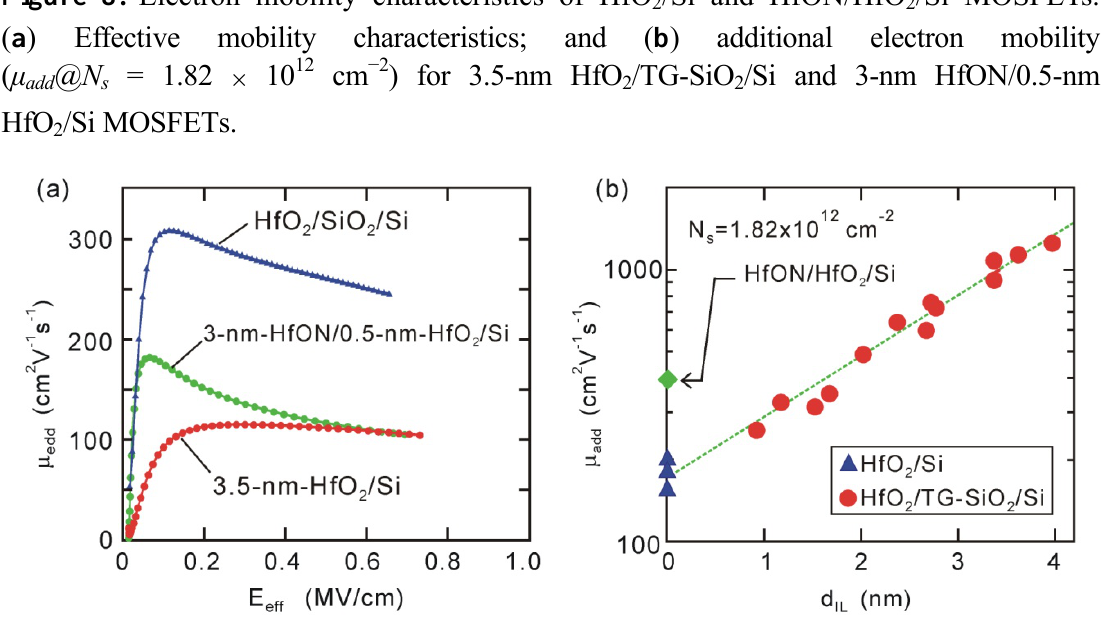
Figure 8. Electron mobility characteristics of HfO